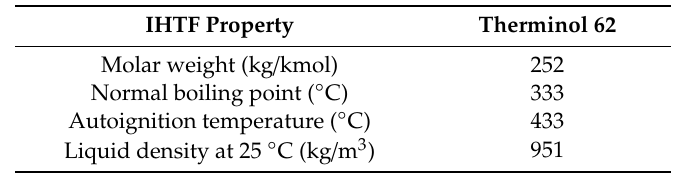
Table 3. Main properties of selected IHTF [22].